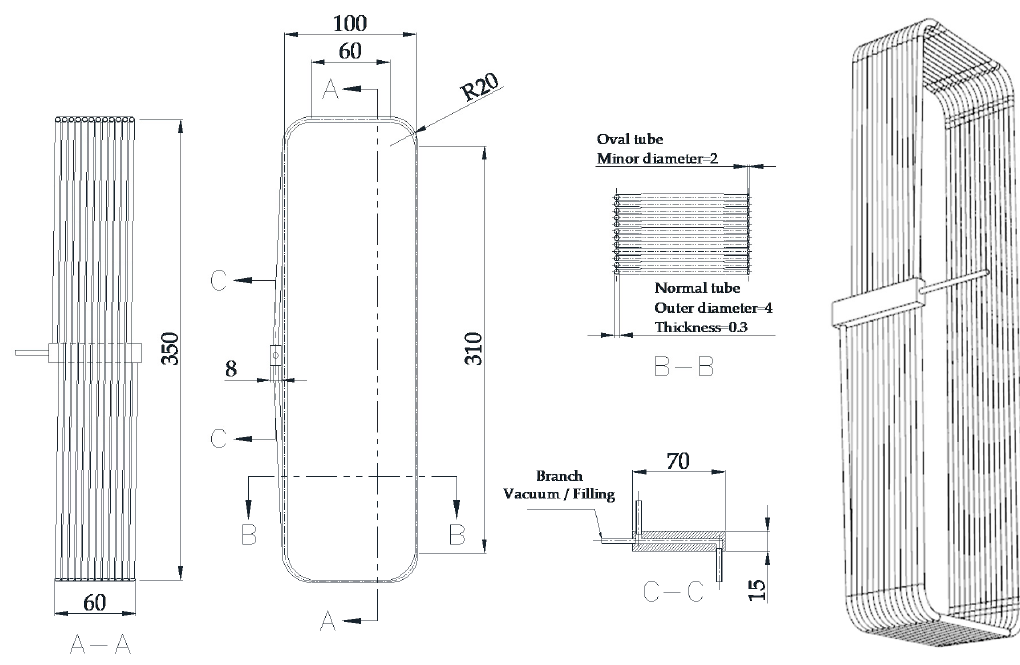
Figure 4. Relative heat spreading resistance percent for relative width ratio.